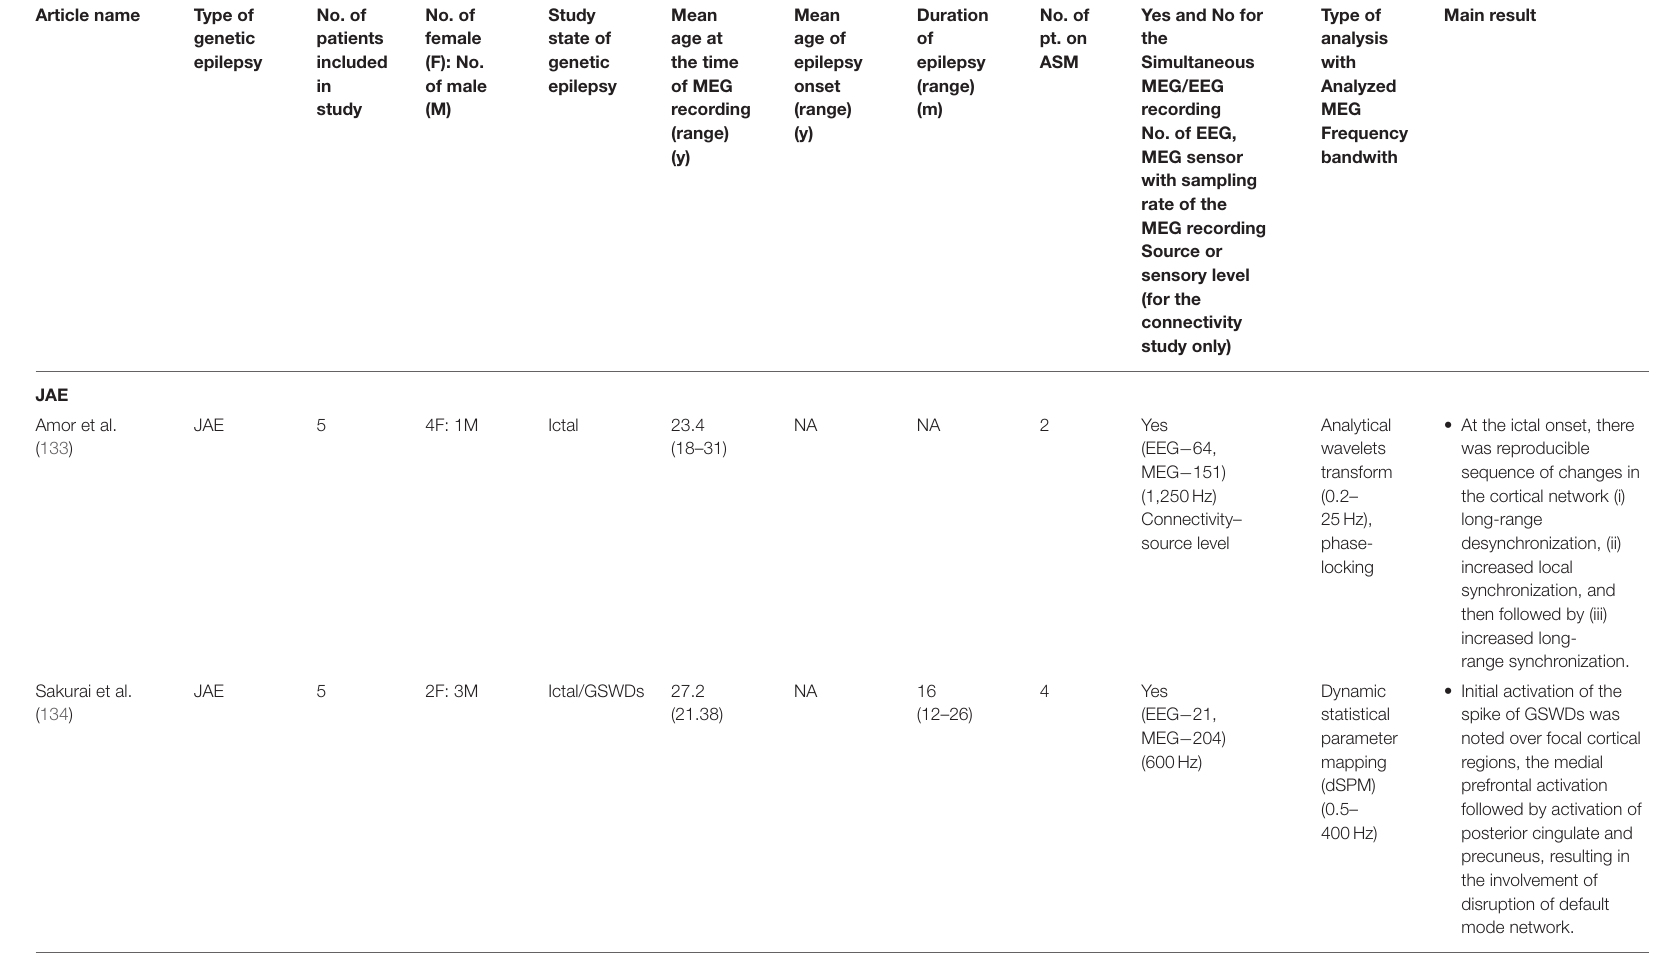
TABLE 2 | Showing all the published study characteristics and main outcomes on juvenile absence epilepsy and combined absence